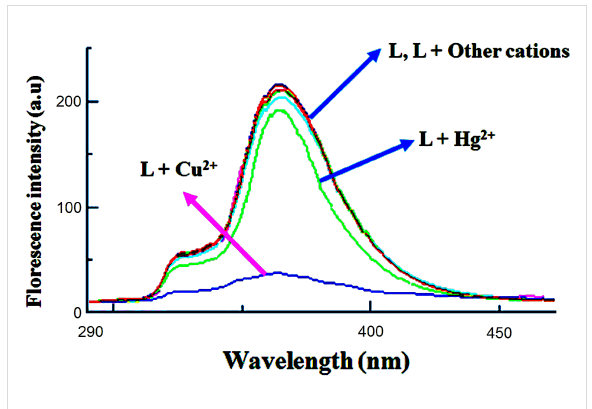
Figure 4: Fluorescence spectra of L (1.0 × 10 − 5 M) in MeCN upon ad- dition of different metal ions (10 equiv) with an excitation at 280